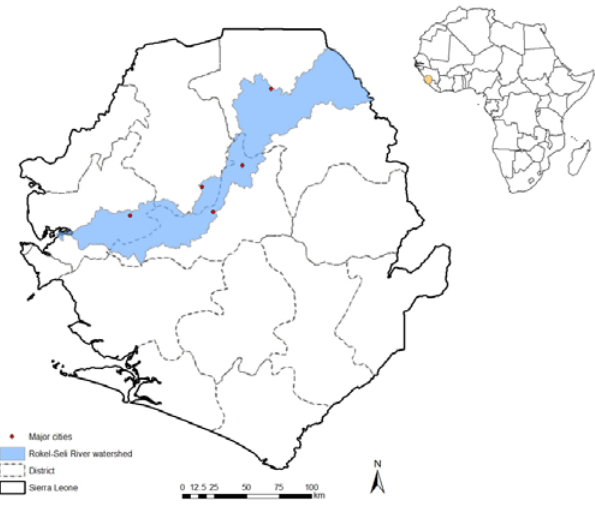
Figure 1. Map of study area: Rokel-Seli River watershed, Sierra Leone,